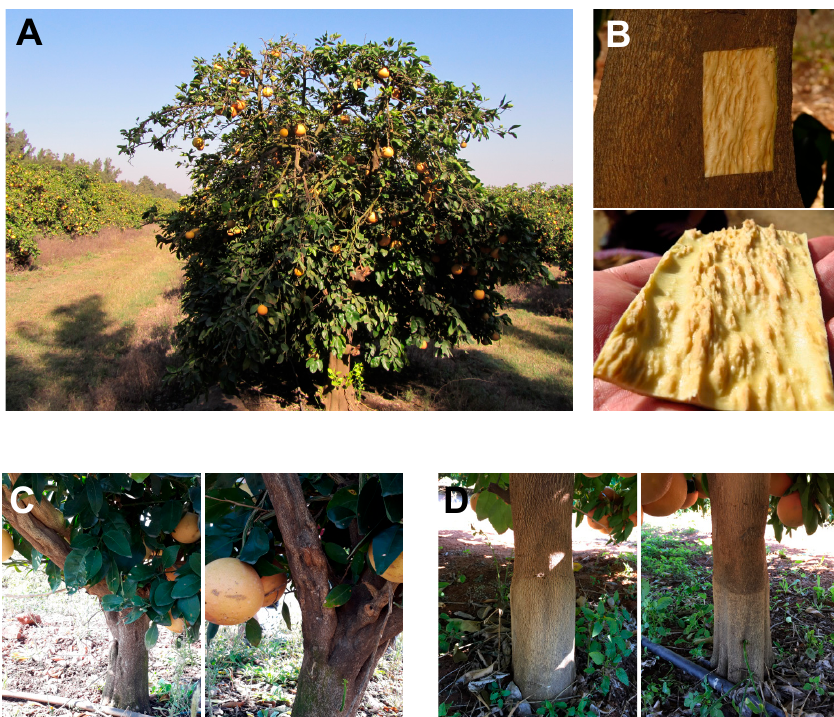
Figure 1. CTV-induced stem pitting. ( A ) A field citrus tree showing stem pitting. ( B ) Pits on the scion part of a trunk of a citrus tree affected by the CTV-induced stem pitting along with the corresponding piece of bark peeled from the tree trunk. ( C ) Trunks and lateral branches of Star Ruby grapefruit trees affected by stem pitting. ( D ) Trunks of cross-protected Star Ruby grapefruit trees. Images were kindly provided by Dr. Glynnis Cook.